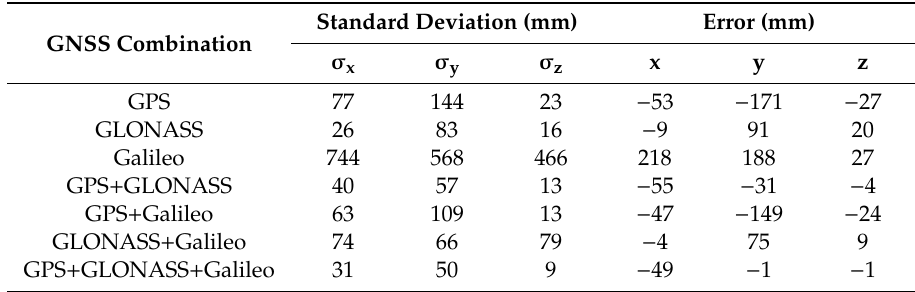
Table 6. Standard deviations and errors of the considered GNSS combinations with Estimate ZTD tropospheric models (outlier